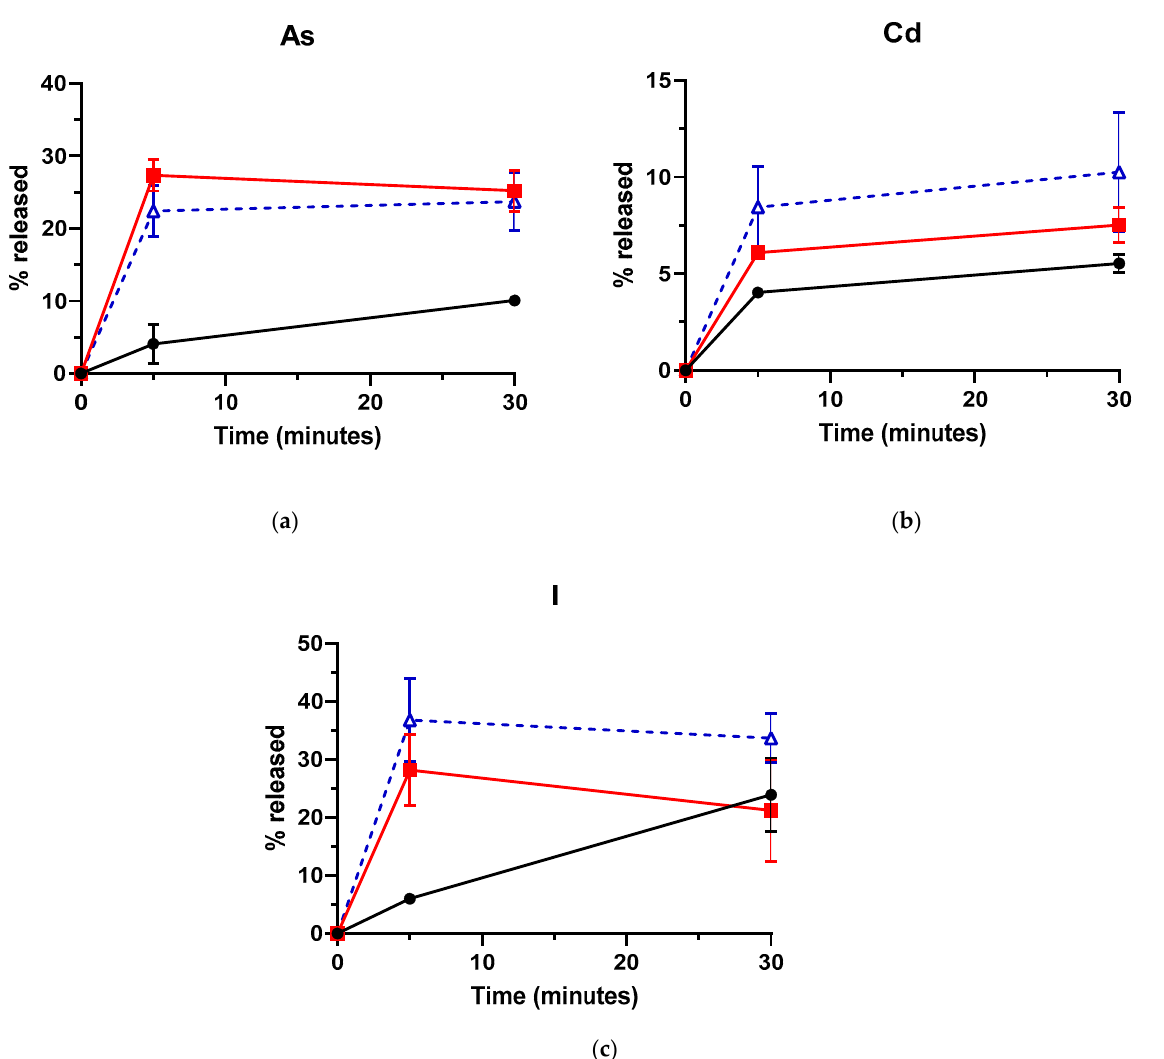
Figure 2. Influence of treatment temperature on the percentage of arsenic (As) ( a ), cadmium (Cd) ( b ) and iodine (I) ( c ) released from Laminaria hyperborea blades after Ultrasound treatments. Treatment temperature: 8 °C ( ● ), 50 °C ( ) and 80 °C ( ). Error bars correspond to the standard deviations.